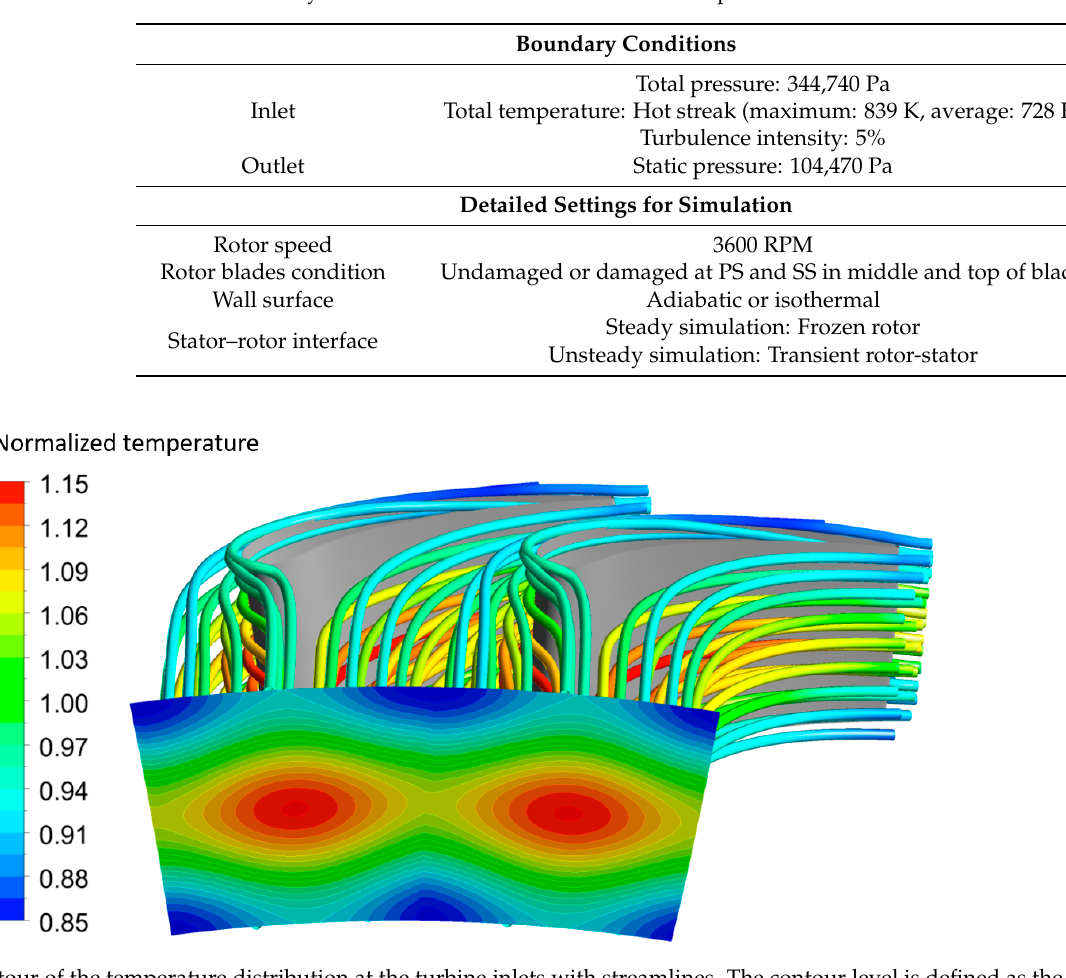
Table 2. Boundary conditions and detailed simulation setup.